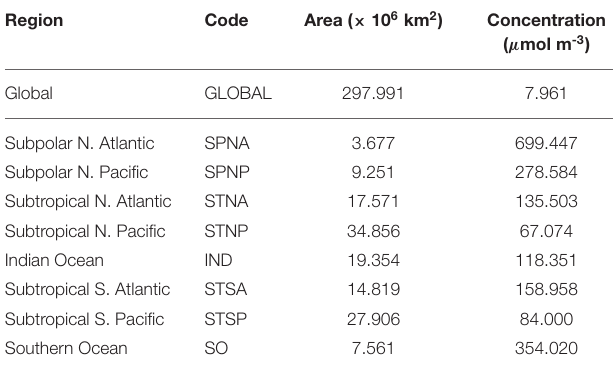
TABLE 1 | Alkalinity enhancement input regions as illustrated in Figure 1 , region name abbreviation (code), region surface area and mean concentration of the alkalinity input over the simulation